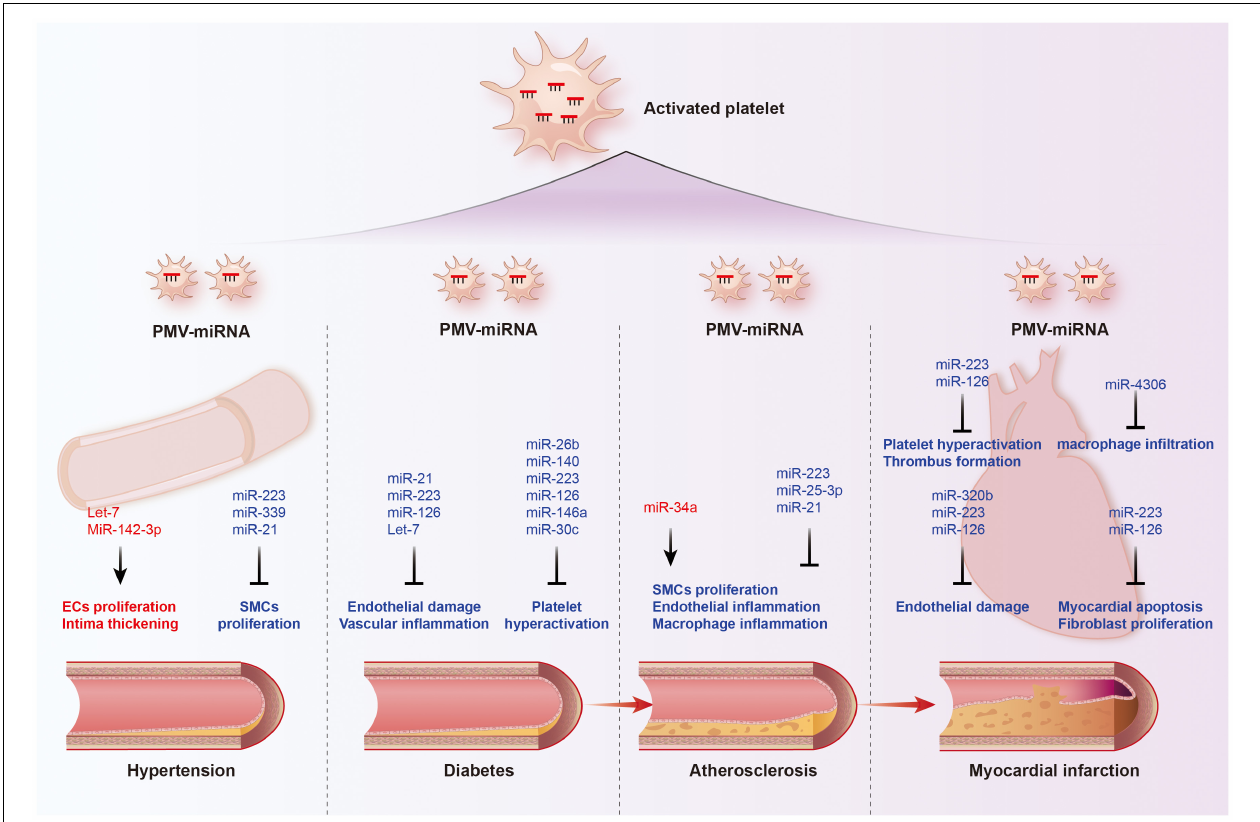
FIGURE 4 | Functions of platelet-derived miRNAs in cardiovascular diseases. The transport of miRNAs from platelet microvesicle (PMV) to the cardiovascular system participate in the occurrence and development of hypertension, diabetes, coronary heart disease, and myocardial infarction, involving multiple mechanisms such as endothelial homeostasis, smooth muscle cell proliferation, inflammatory cell infiltration, and cardiomyocyte apoptosis. Red labeled miRNAs promoted their downstream processes, while blue labeled miRNAs inhibited the downstream